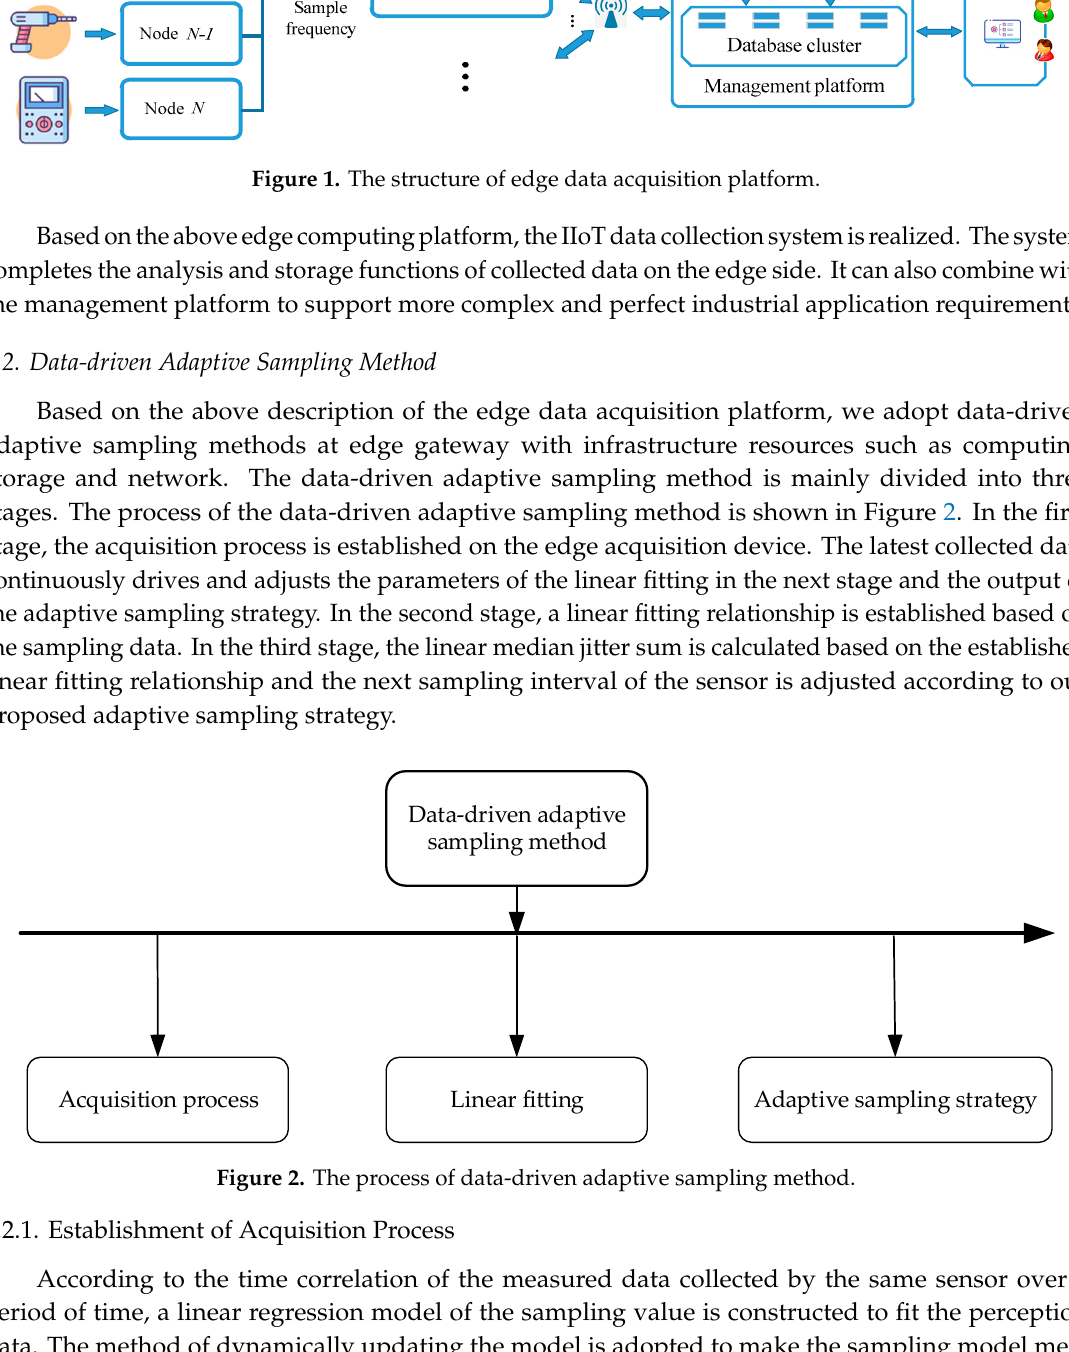
Figure 1. The structure of edge data acquisition platform.